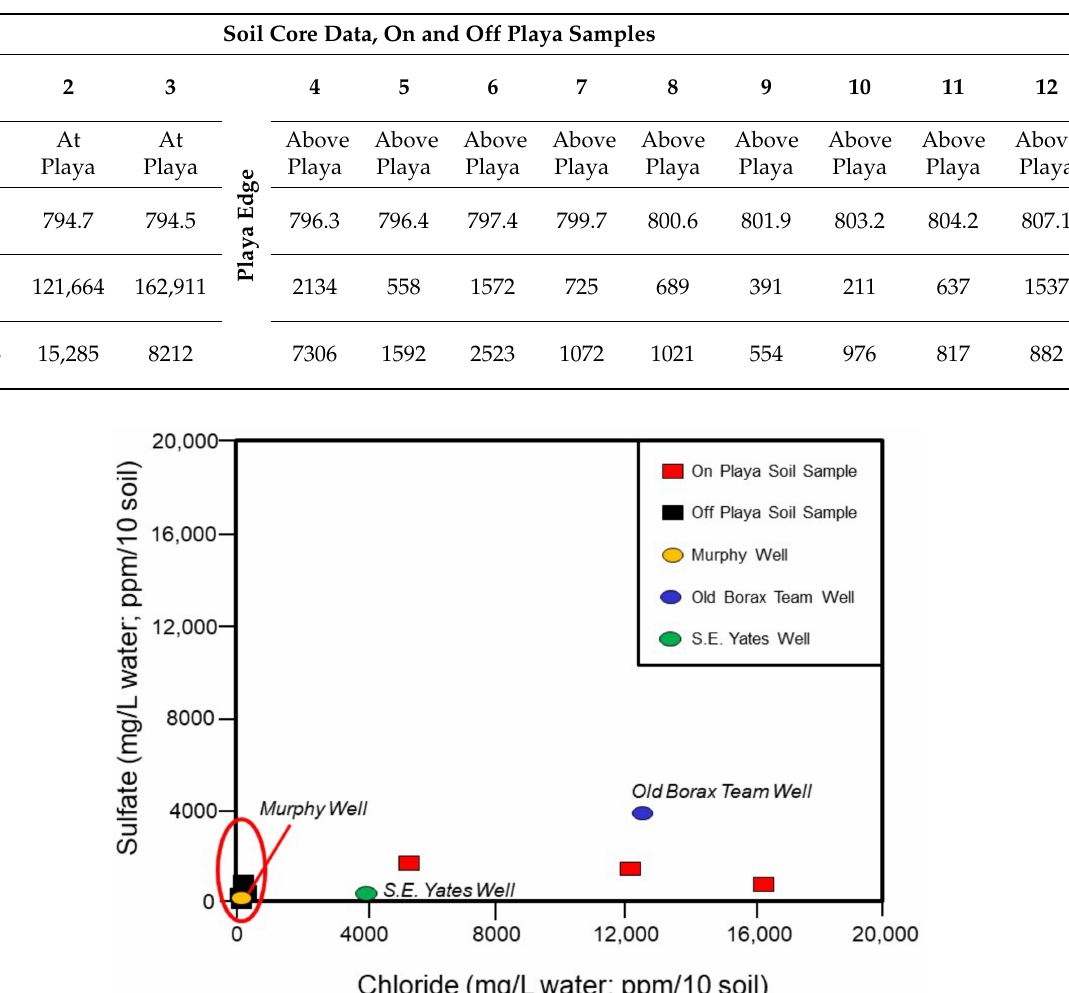
Table 3. Soil chemistry data from soil cores collected at and above Ivanpah Playa (from Sims and Spaulding, 2017).